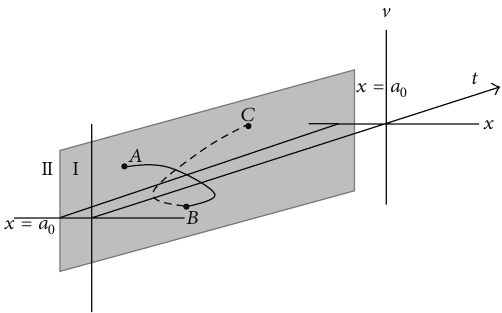
Figure 3: The three-dimensional trajectory and the Poincare sec-